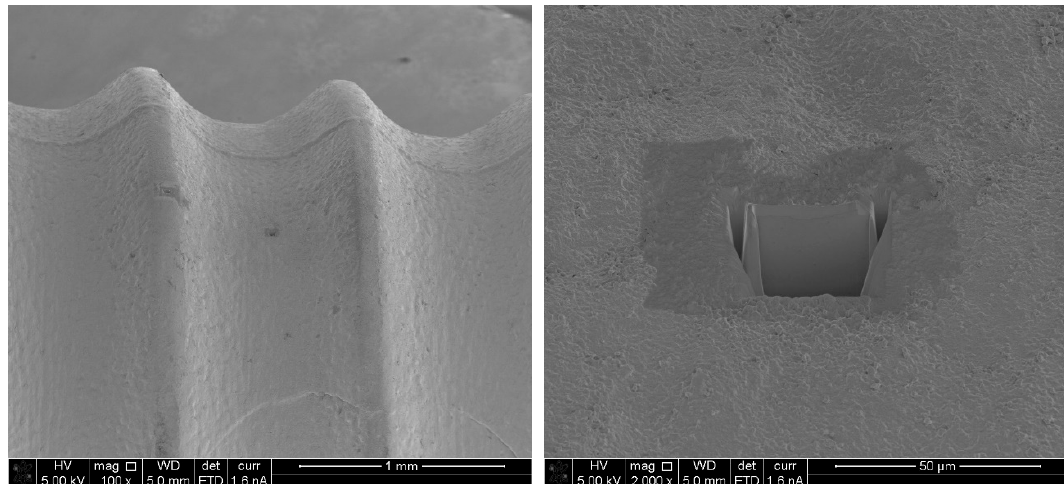
Figure 4. Exemplary Focused Ion Beam (FIB)-sections on the endosseous part of a zirconia dental implants.